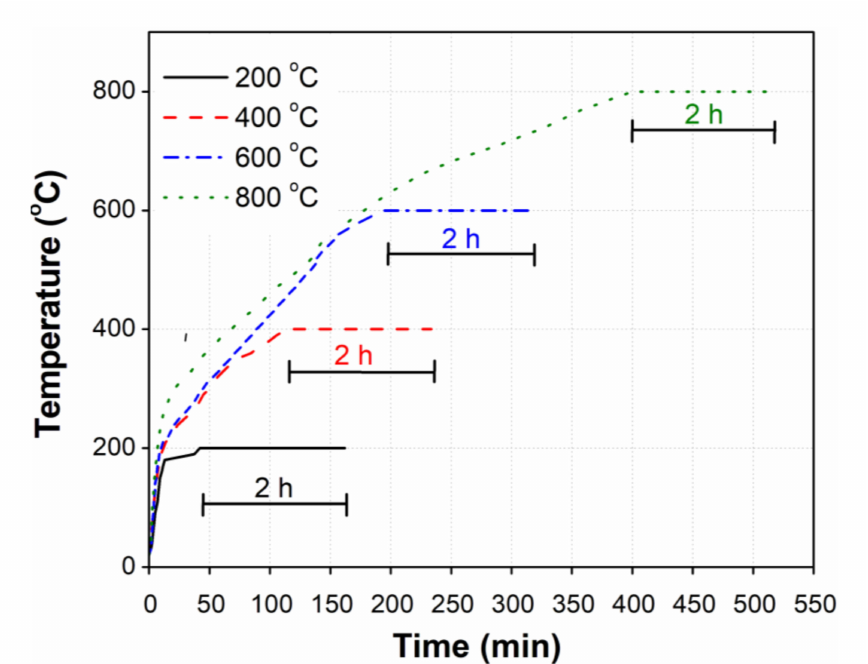
Figure 4. Temperature variation inside the furnace for different elevated